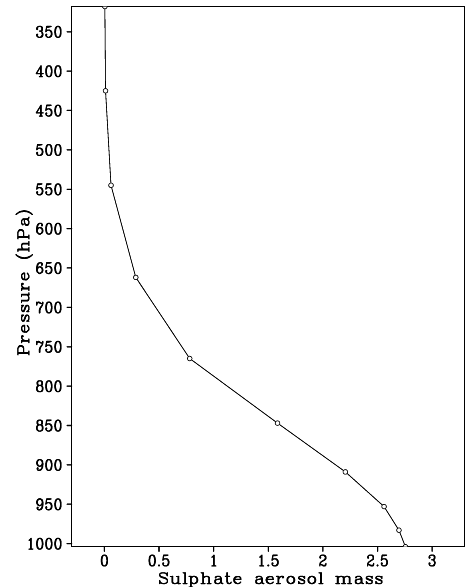
Fig. 11. Averaged vertical profile of sulphate aerosol mass (µg m − 3 ) over the entire INDOEX region for the IFP.